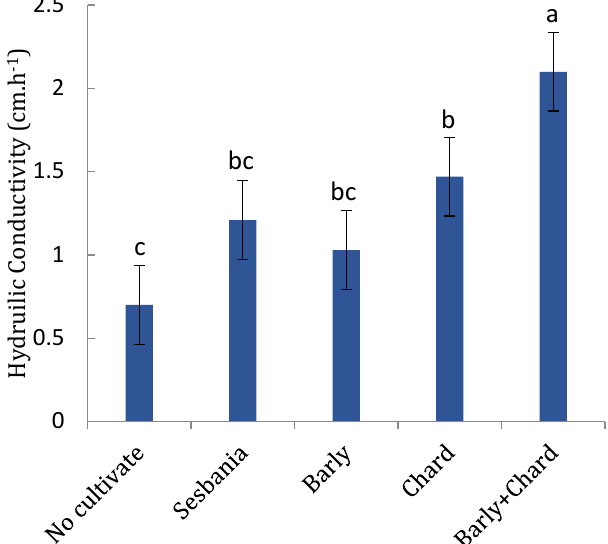
Figu re 3. Phytomanagemen t effe ct on th e soil hydraulic conductivity (cm.h -1 ) of the surfac e laye r (0-30cm ) after three s easons. Values rep resen t mean ± S